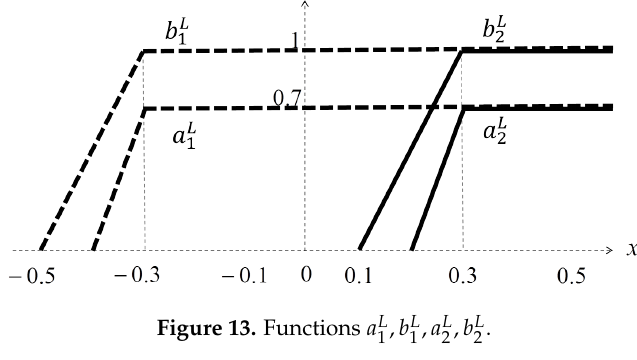
, b L , a L , b L . 2 2 1 1